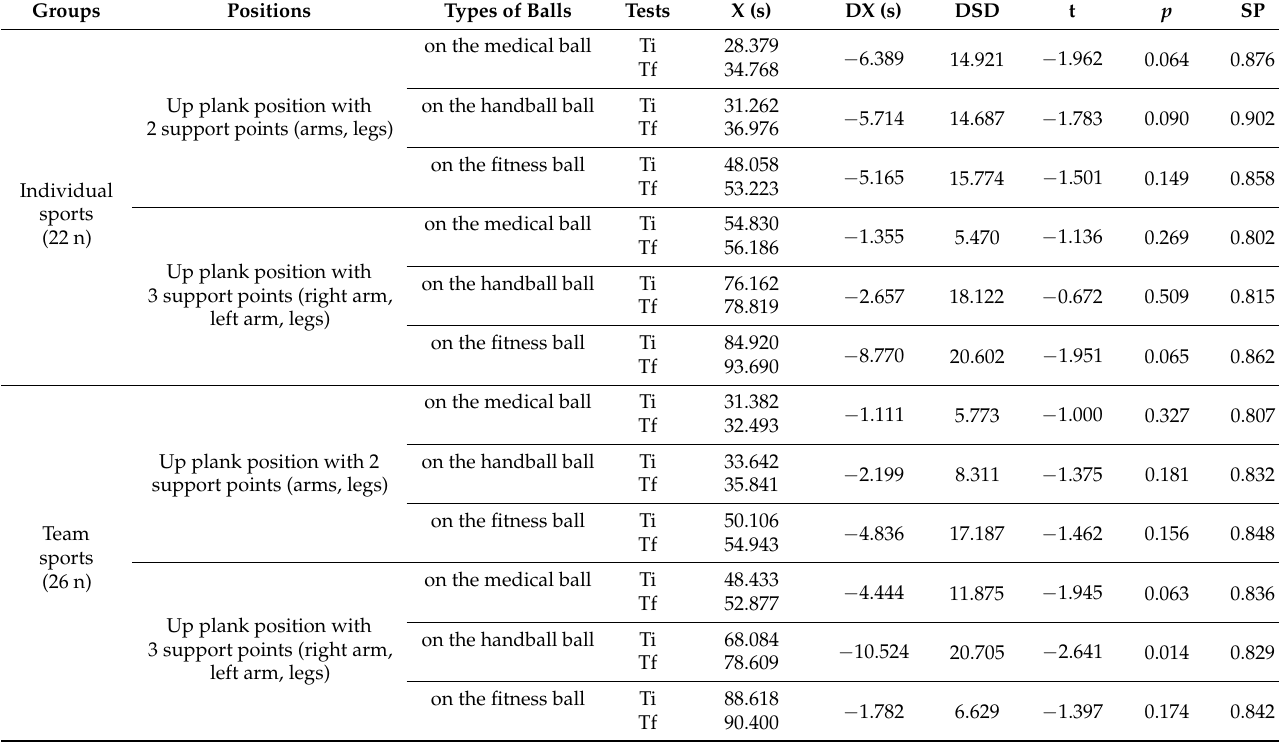
X—mean, DX—differences of mean, DSD—differences in Std. Deviation, t—value of Student test, SP—statistical power, p—level of probability, Ti—initial test, Tf—final test, n—number of